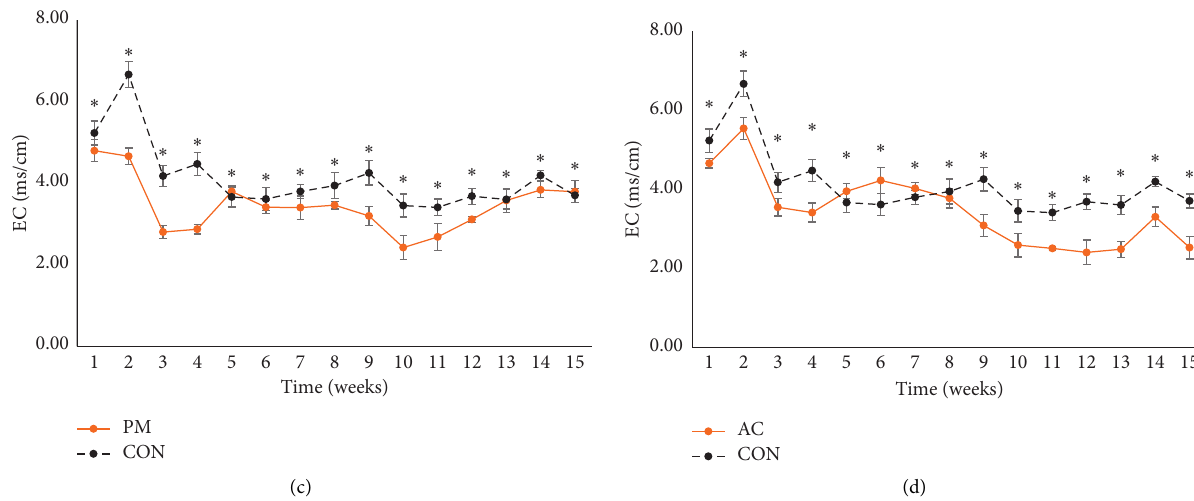
Figure 5: Soil EC values over 15 weeks of treatment; (a) molasses vs. control; (b) compost vs. control; (c) papermill sludge vs. control; and (d) activated carbon vs. control. M: molasses; C: plant compost; PM: papermill sludge; AC: activated carbon; and CON: control. ( ∗ ) indicates that data for the treatment were significantly different ( p < 0.05) from the